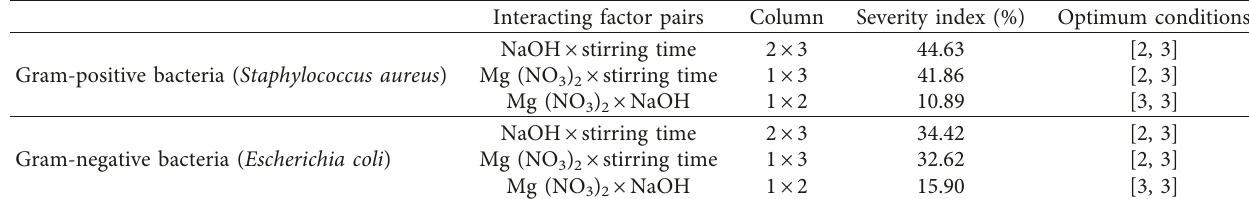
Table 3: The interactions among studied factors at different levels on the survival rate of